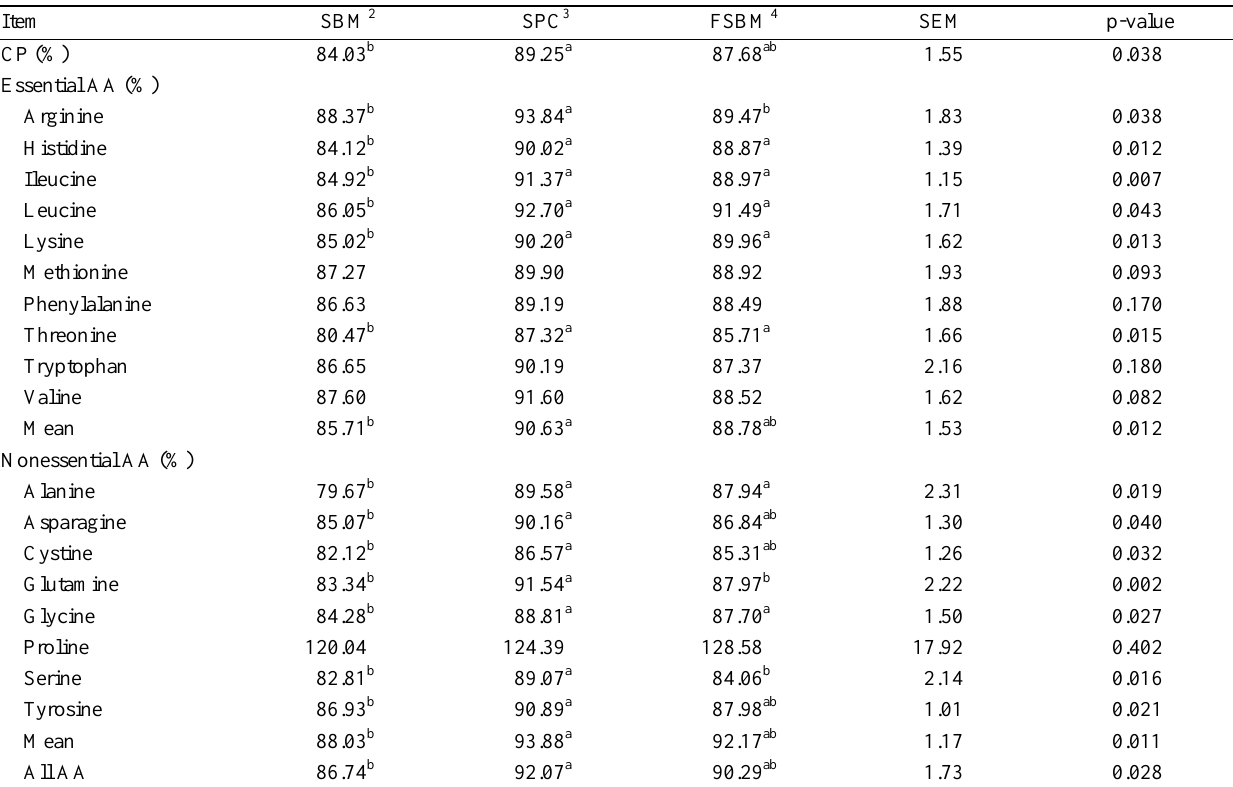
Table 6. SID of CP and AA in soybean meal (SBM), soy protein concentrate (SPC) and fermented soybean meal (FSBM), Exp.2